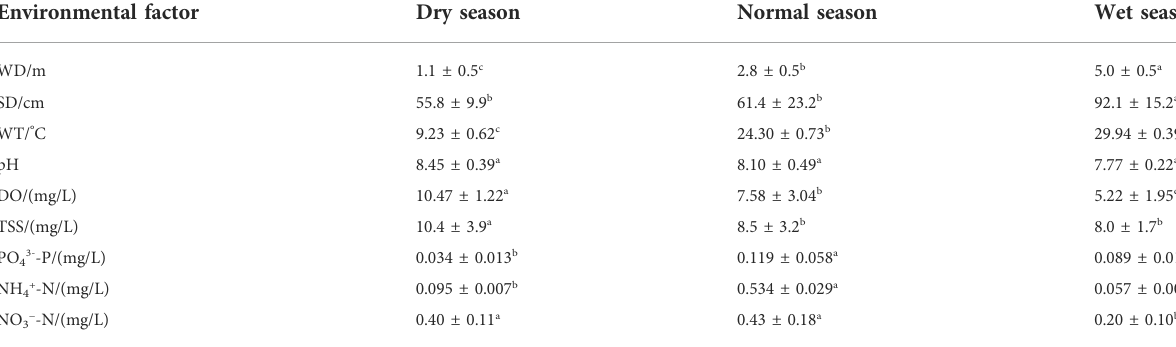
TABLE 6 Variations in environmental factors in different hydrological